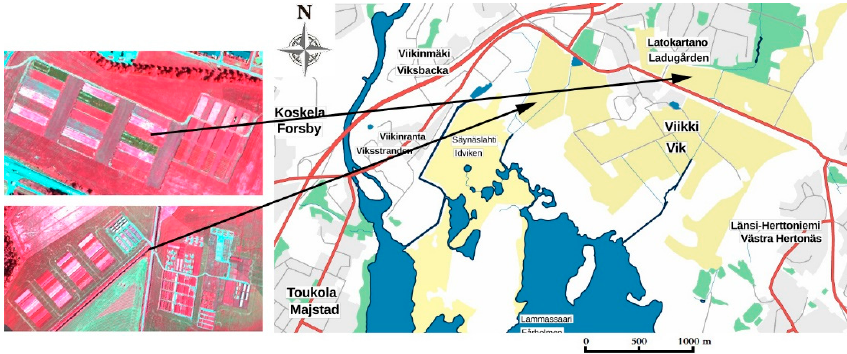
Figure 1. A map of the field site and aerial imagery of field